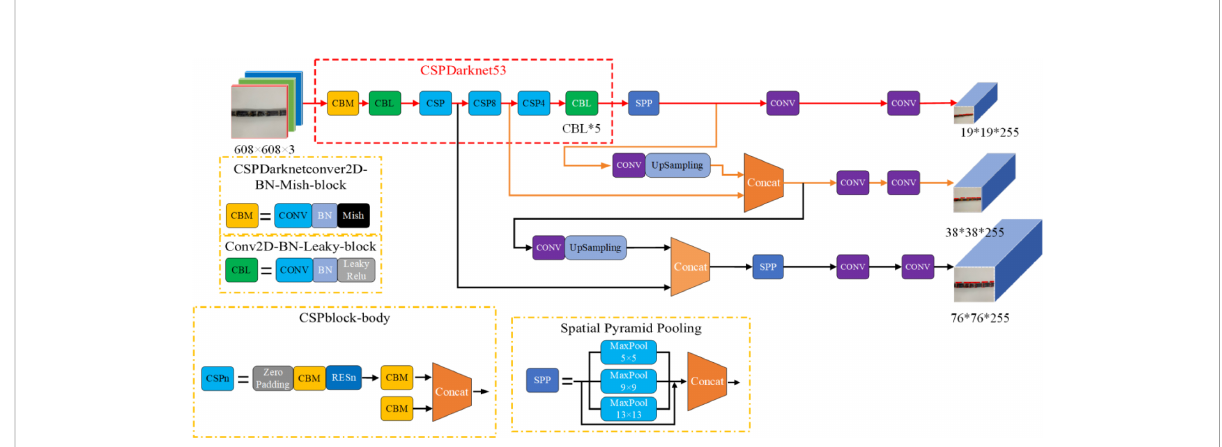
FIGURE 6 Enhanced YOLOv4-Tiny network structure.